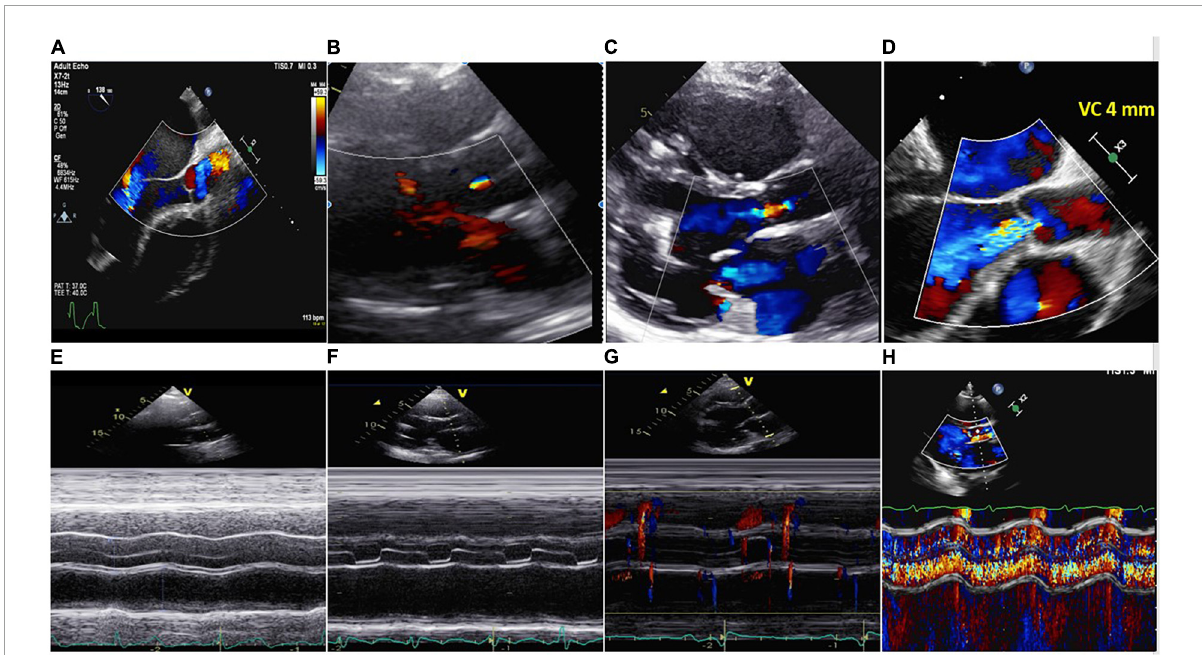
FIGURE5 Upper part: (A) No aortic regurgitation (AR); (B) trivial AR; (C) mild AR; (D) severe continuous AR (VC 4 mm). Lower part: (E) Closed AV; (F) aortic valve open in end diastole and systole. No AR; (G) aortic valve opened in systole. No AR; (H) same patient of panel (D) . M-Mode showing severe systolic-diastolic AR. The valve was closed during the cardiac